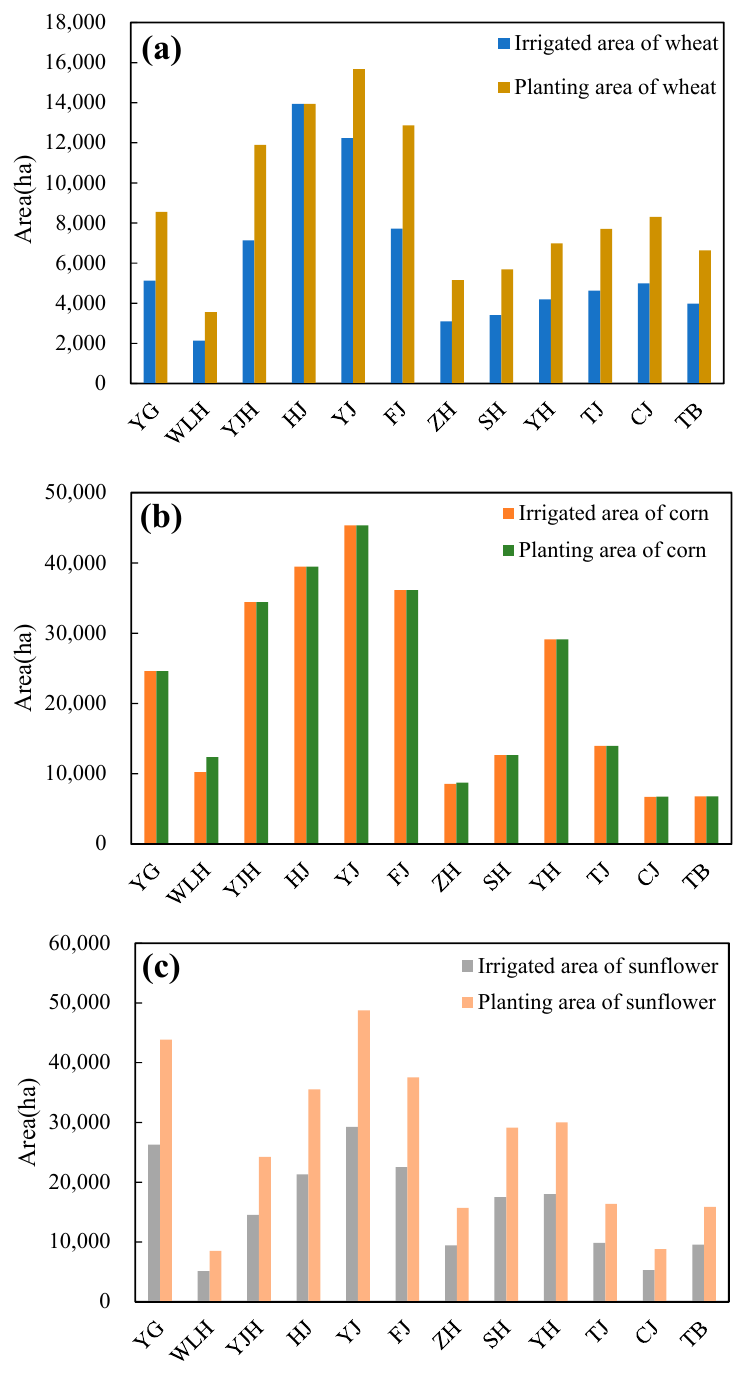
Figure 10. Optimization results of irrigated area: ( a ) Wheat; ( b ) corn; ( c )